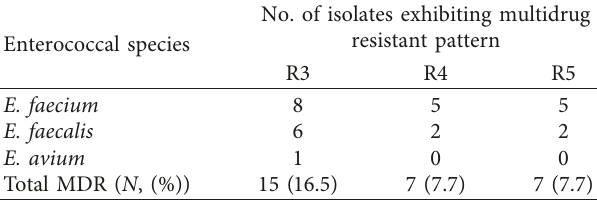
Table 5: Multidrug resistance profile of Enterococcus . Enterococcal